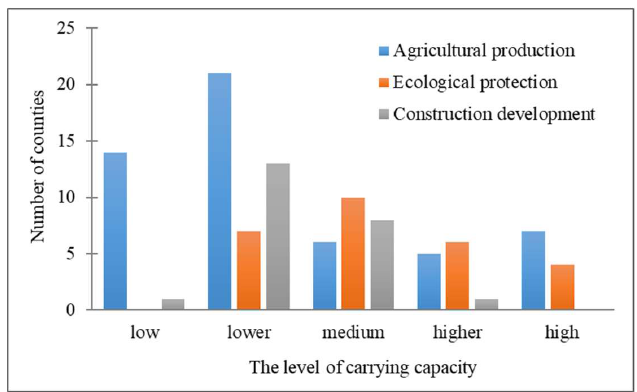
Figure 9. Number of functional areas of di ff erent levels of RECC in